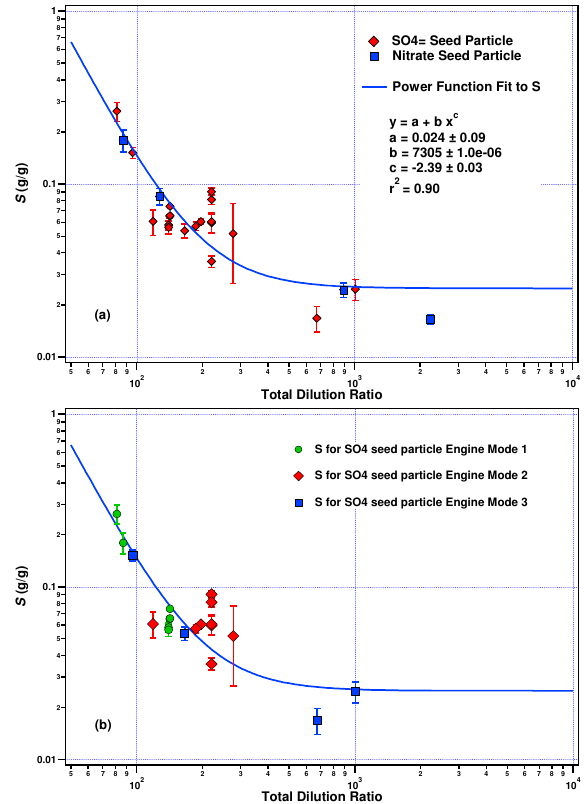
Figure 4. The amount of dissolution S of the organic matter in the inorganic seed particles (condensed organic mass per unit mass of seed particles) in g/g unit versus total dilution ratios from 81 to 2230. The uncertainties in S are derived from the linear fits to COM versus seed particle mass. (a) Red diamonds are for for (NH 4 ) 2 SO 4 seed particles of all engine modes; blue squares are for NH 4 NO 3 seed particles in engine mode 1. (b) S for (NH 4 ) 2 SO 4 seed particles in engine modes 1, 2, and 3.